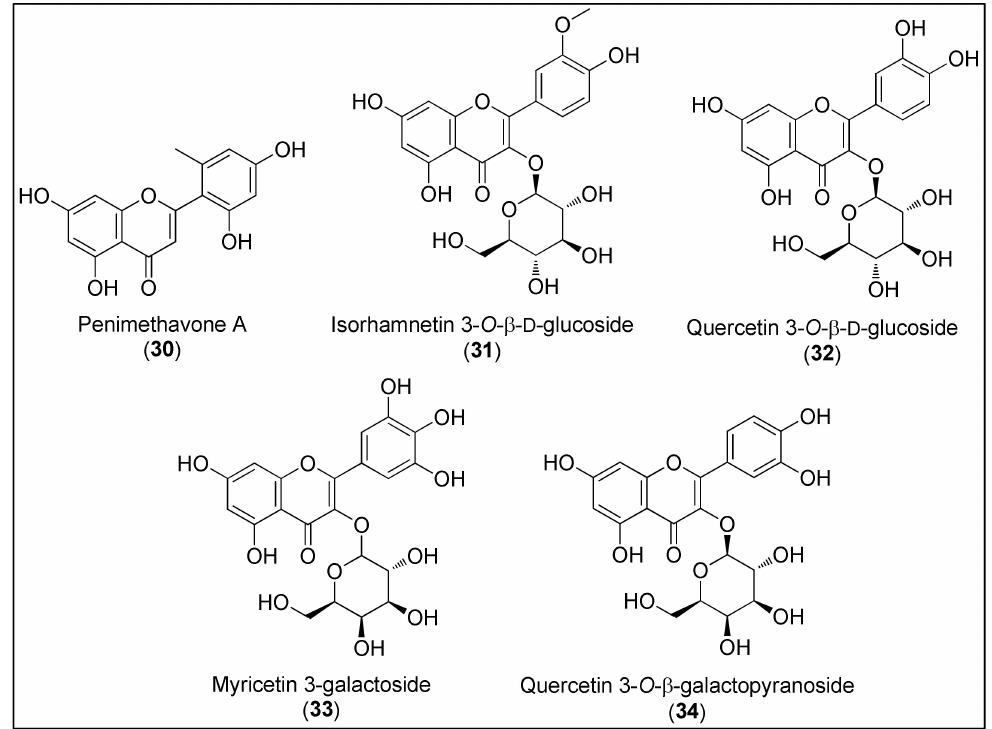
Figure 3. Chemical structures of flavonoids, penimethavone A ( 30 ), isolated from fungus Penicillium chrysogenum and flavonoid glycosides 31 – 34 isolated from the halophytes, Salicornia herbacea and Limonium tetragonum